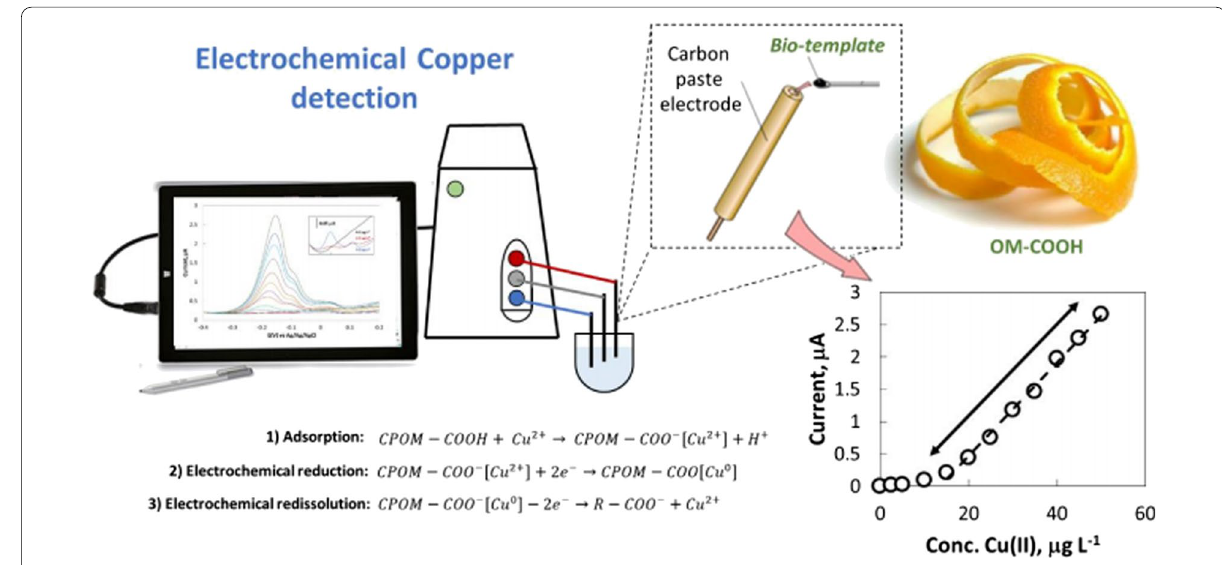
Fig. 5 Mechanism of Cu(II) detection (Romero-Cano et al.